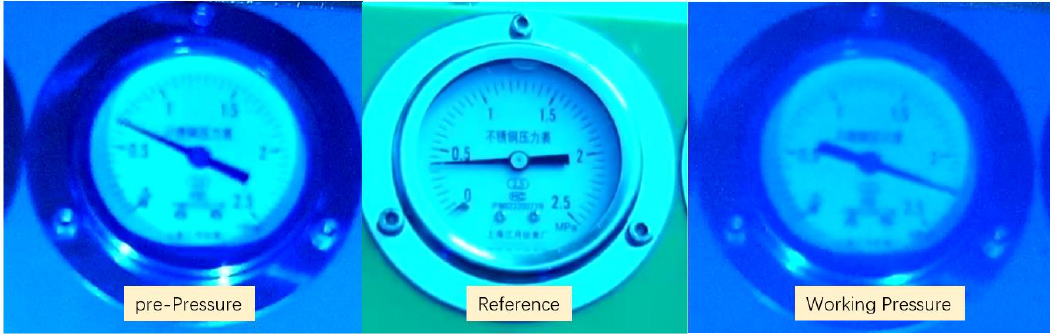
Figure 19. Pressure of arm cylinder during the 2020 sea trials. (3)